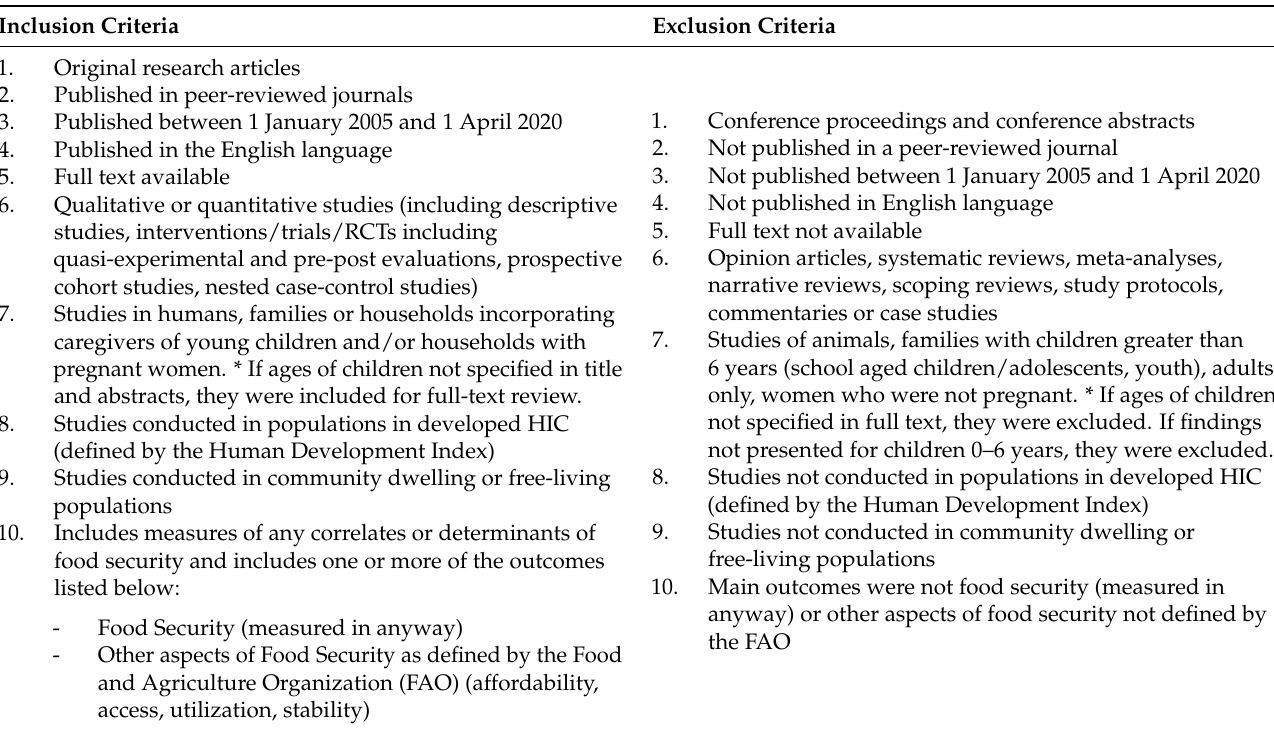
Table 1. Inclusion and exclusion criteria used for abstract and full-text